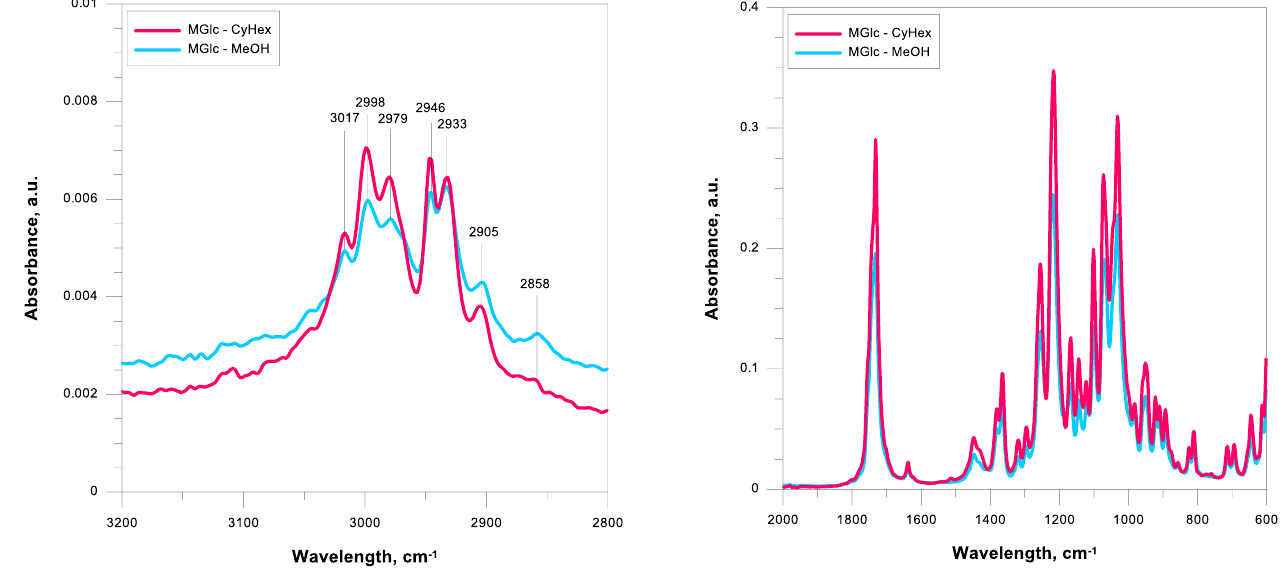
Figure 9. FTIR spectra of MGlc monomer crystallised from methanol (blue line), and cyclohexane (red line).